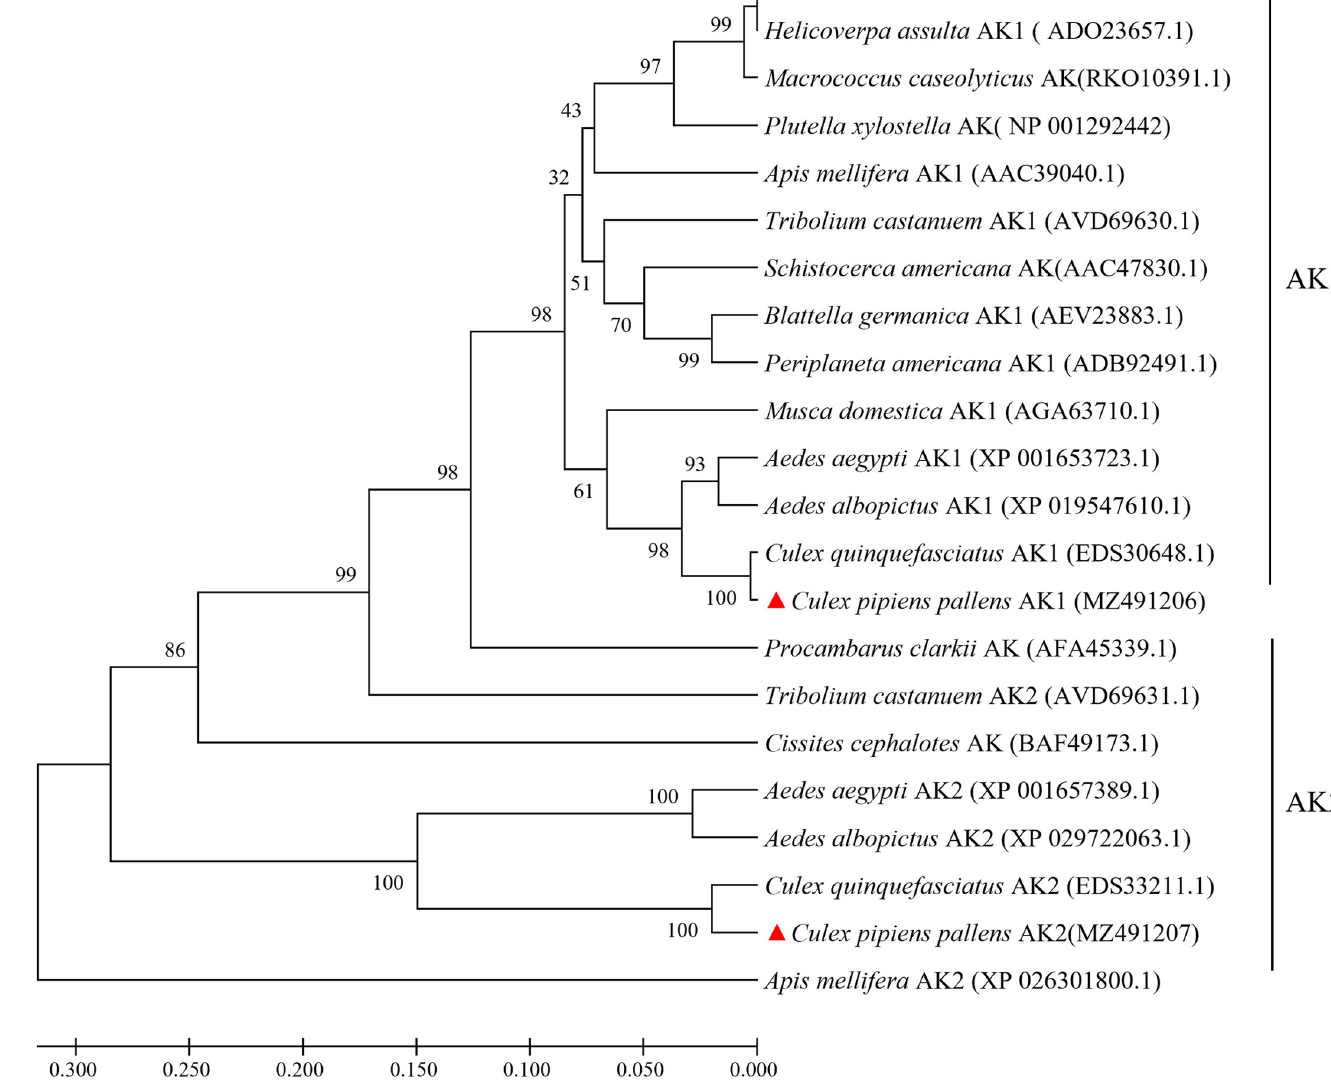
Fig 2. Phylogenetic analysis of arginine kinase genes from Cx . pipiens pallens and other insects. The phylogenetic tree was constructed using MEGA7 with a boot strapping of 1000 iterations, and an arginine kinase gene (RKO10391.1) from Macrococcus caseolyticus was used as an outgroup.